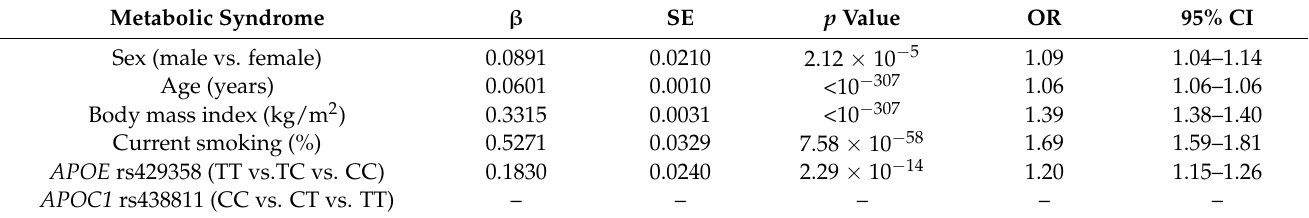
Table 4. Logistic regression analysis for metabolic syndrome, including APOE and APOC1